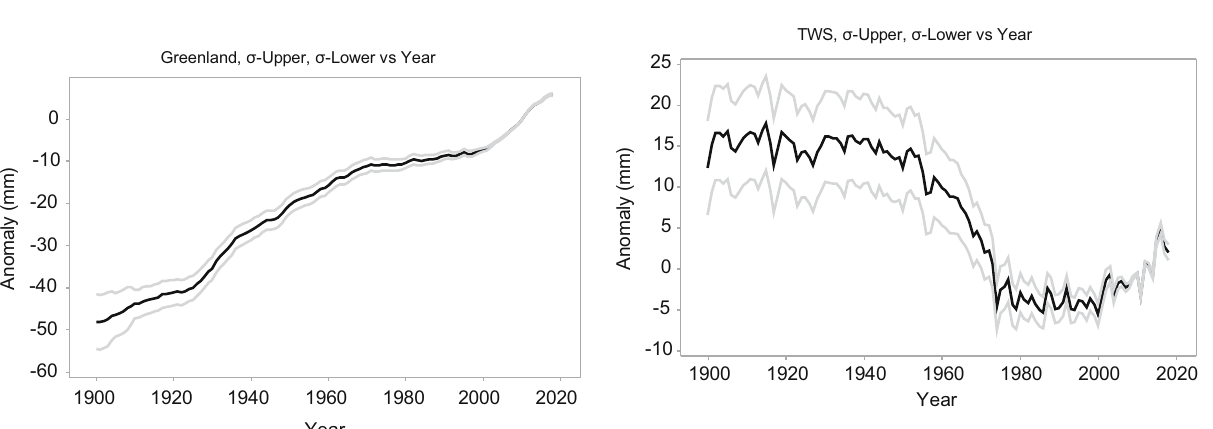
Figure 3: Yearly averaged anomalies of Greenland component and their a priori uncertainties ( SE ) during 1900 – 2018 ( Frederikse et al. 2020 ) .